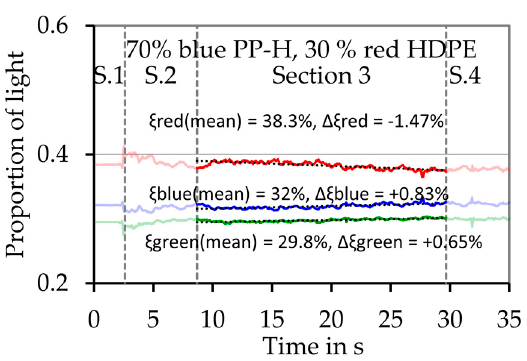
Figure 17. Exemplary result of the optical evaluation of the melting experiment for a mixture of 70 wt.% blue PP-H, grade B and 30 wt.% red HDPE. The dashed line shows the transitions between the four sections.